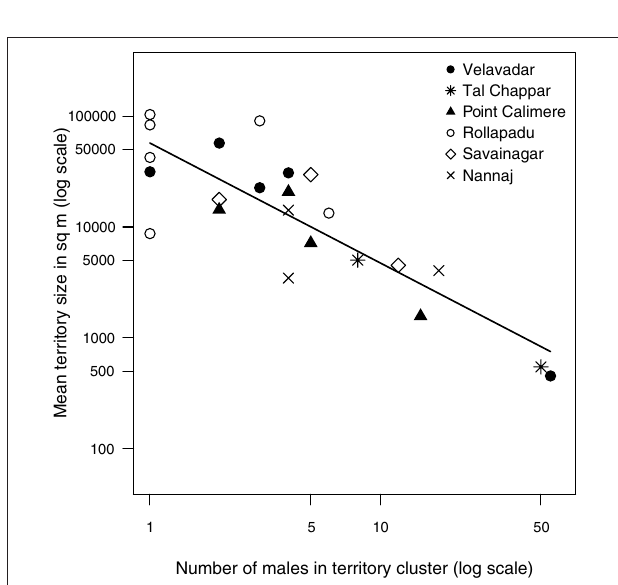
FIGURE 3 | Relationship between the number of territorial males in a cluster and mean territory size pooling together data from six blackbuck populations. Mean size of territories in a cluster decreased rapidly with the number of males in a cluster. Each data point represents a cluster and is an average of the size of a sample of territories from that cluster (range = 1–15 territories). Each set of symbols represents clusters from a particular population. The relationship is strongly non-linear and hence the data have been log-transformed to obtain a better view of the pattern. The line represents the model prediction from a linear model (see